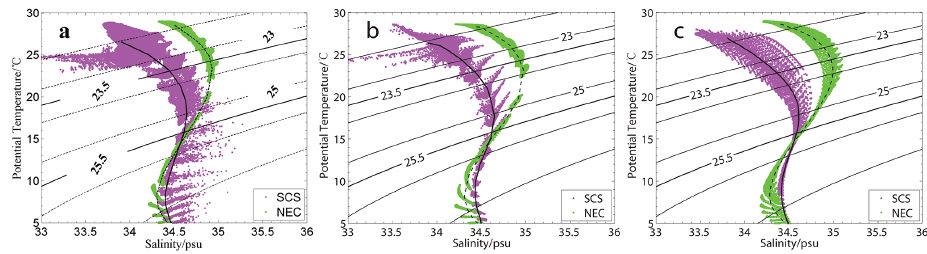
Figure 2. T-S diagram at the two black boxes in Fig. 1: (a) HYCOM; (b) WOA01; (c) MIMOC. Pink and green dots represent the selected waters in the SCS and Pacific, respectively.